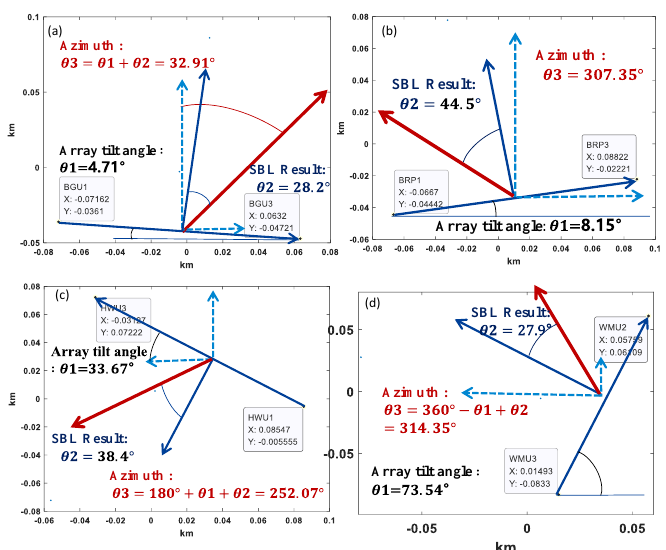
Figure 10. The azimuths obtained from the BGU station, BRP station, HWU station, and WMU station are ( a ) 32.91°, ( b ) 307.35°, ( c ) 252. 07°, and ( d ) 314.35°, respectively (the array tilt angle is defined as